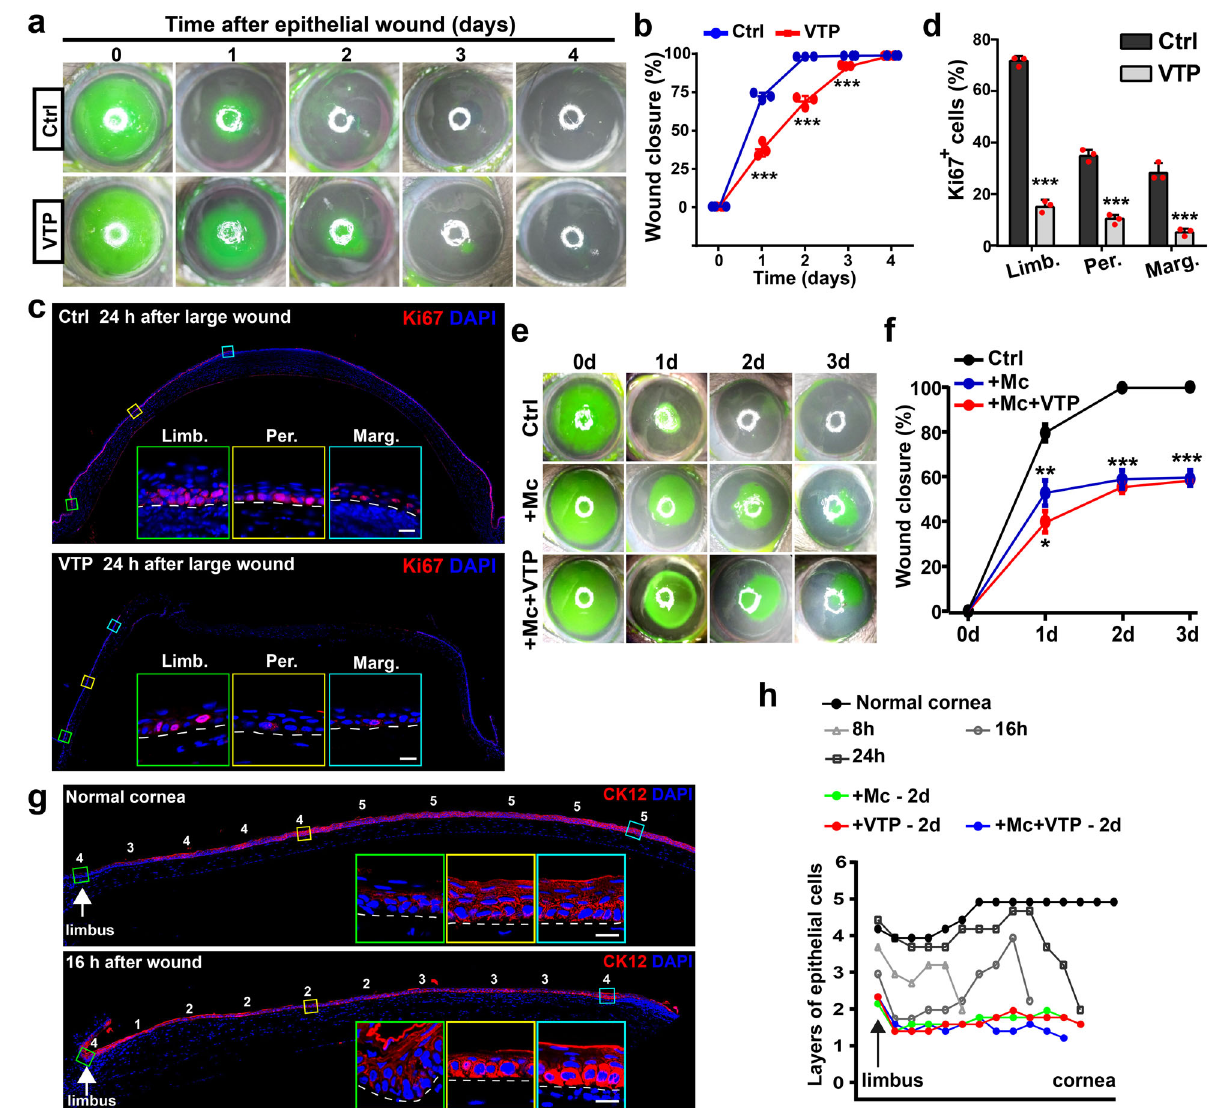
sodium at 0, 1, 2, 3, and 4 days after wound. Quanti fi cations of wound closure (%) at 0, 1, 2, 3, and 4 days. c , d Proliferation (Ki67-positive) of regenerative epithelial cells at 24 h pw without or with VTP treatment. Quanti fi cation of percentages of Ki67-positive regenerative epithelial cells at 24 h pw without or with VTP treatment. e , f The corneal epithelial defects are stained with fl uorescein sodium at 0, 1, 2, and 3 days after 4 mm-diameter wound under indicated conditions. Quanti fi cations of wound closure (%) at 0, 1, 2, and 3 days. + Mc vs Ctrl; + Mc + VTP vs + Mc. g , h CK12 staining of corneal epithelium in normal cornea and during regeneration at 16 h pw. The numbers shown are layers of epithelial cells. Quanti fi cations of epithelial cells layers at indicated time points or under indicated treatments. Scale bars, 20 μ m ( c , g ). Data are the mean ± SD, n = 3 corneas ( b , f ), n = 3 sections ( d ); Data are the mean from four sections ( h ); * p < 0.05, ** p < 0.01, *** p < 0.001 (Student ’ s two- tailed unpaired t -test). Ctrl, 0.1% DMSO; VTP, ver t epor fi n, 10 μ M; Mc, mitomycin C, 5 μ